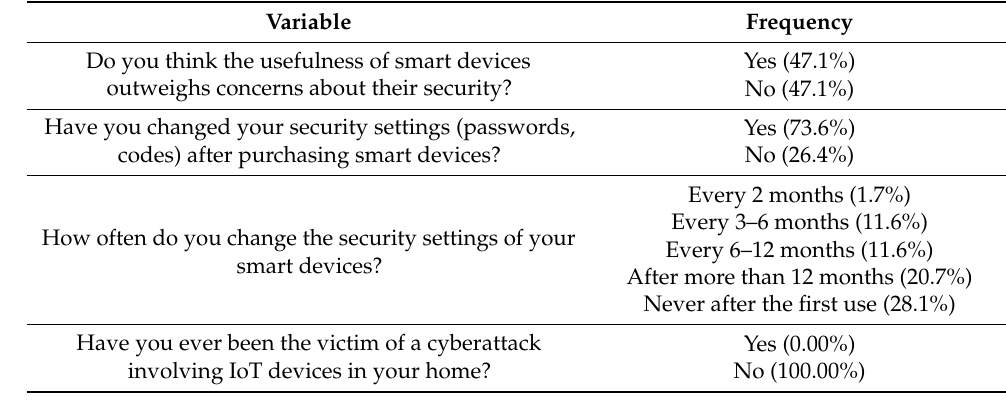
Table 6. Questions regarding the security of IoT devices ( n =